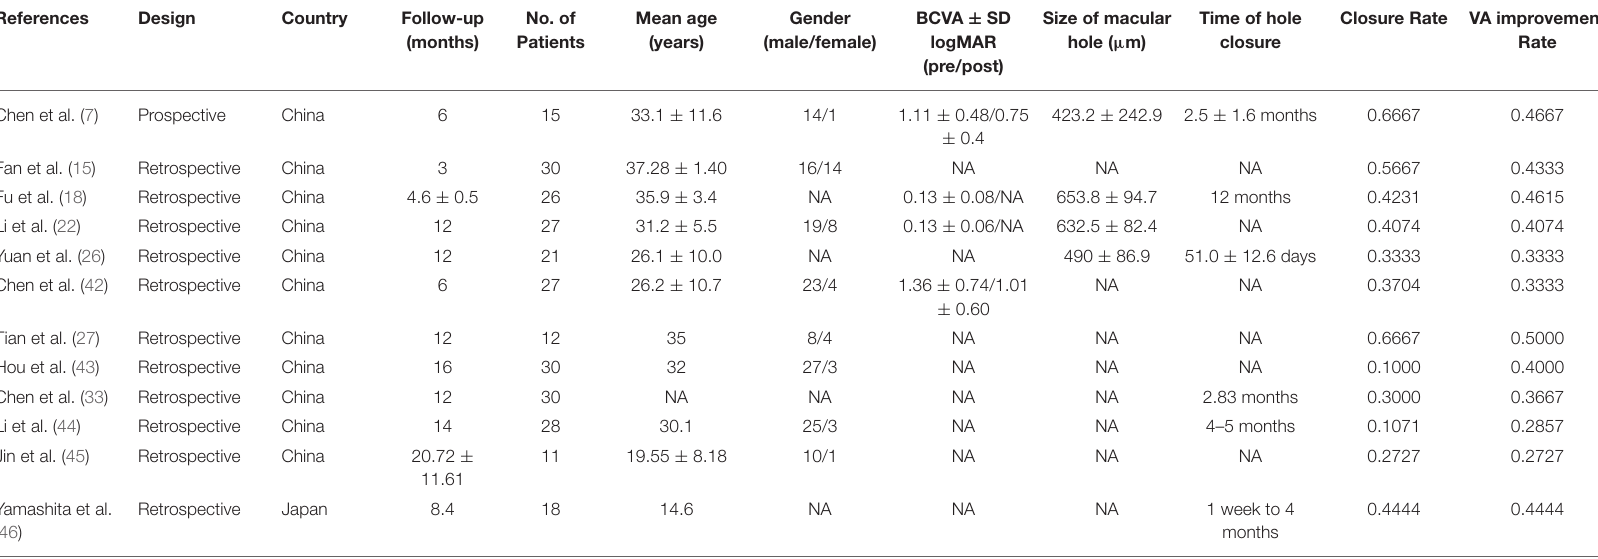
TABLE 2 | Study design and baseline patient characteristics of observation group